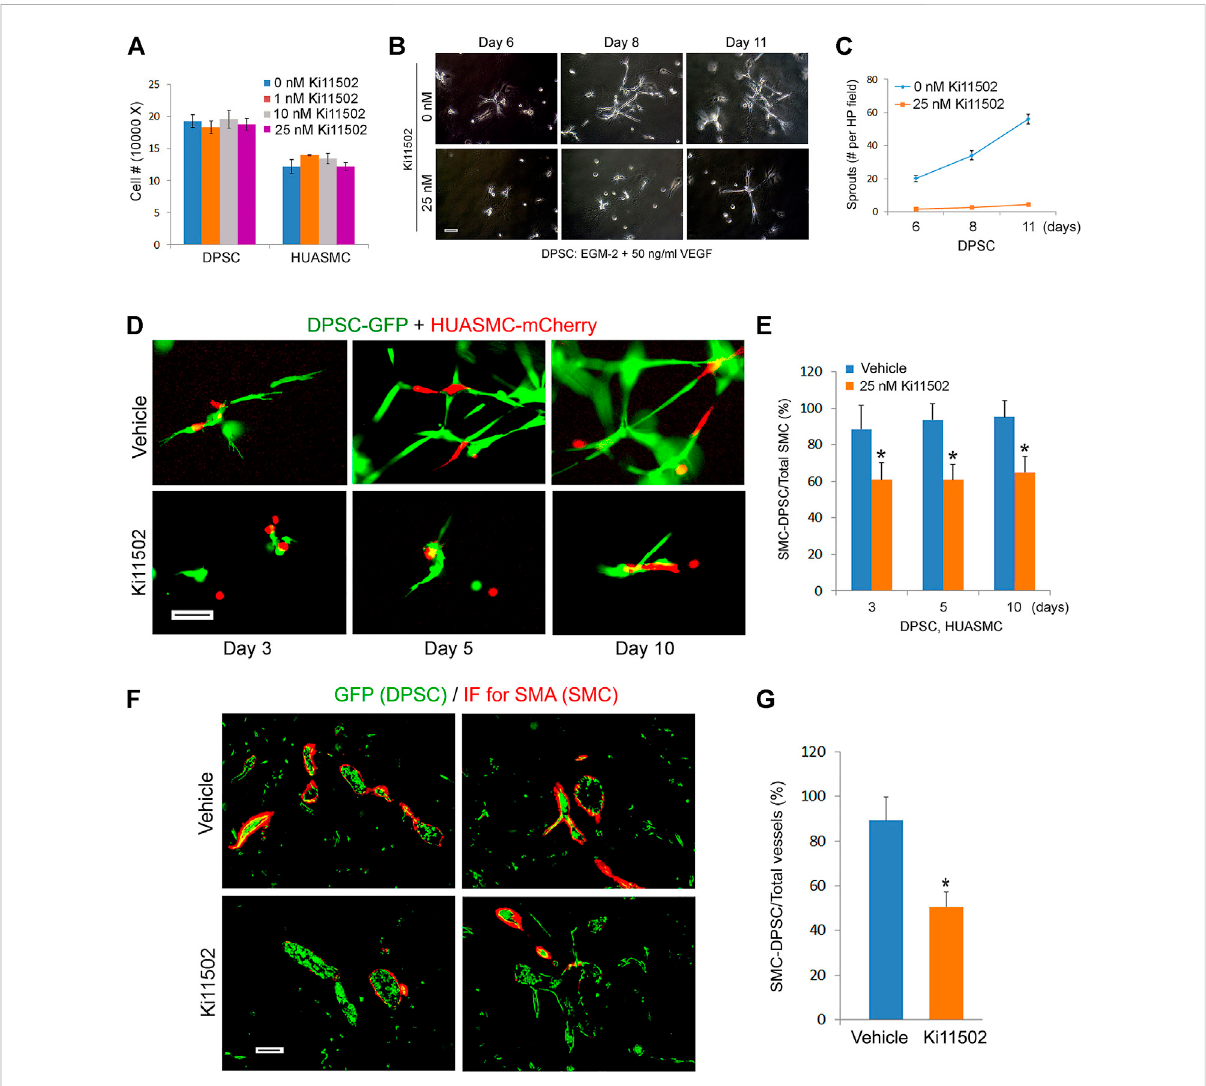
FIGURE 6 Blockade of PDGFR- β signaling inhibits maturation of DPSC-derived blood vessels in vitro and in vivo . (A) 10000 – 50000 DPSC or HUASMC were cultured with α -MEM supplemented with 5% FBS in presence of 0 – 25 nM Ki11502. After 4 days, the number of cells were counted under microscopic evaluation. (B,C) 10000 DPSC were plated in growth factor-reduced Matrigel-coated wells and cultured with EGM2-MV + 50 ng/ml VEGF in presence of 0 or 25 nM Ki11502 (PDGFR inhibitor) for indicated time points. Photomicrographs of capillary-like sprouts. Scale bar: 100 µm. (C) Graph depicting the number of capillary-like sprouts from (B) . (D,E) DPSC (green) and HUASMC (red) were seeded in Matrigel-coated plates and cultured with α -MEM supplemented with 5% FBS in presence of 20 ng/ml bFGF and PDGF-BB in the presence of 25 nM Ki11502 for indicated time points. Vascular networks were photographed. Scale bar: 100 µm. (E) Graph depicting the percentage of HUASMC cells in direct contact with DPSC cells as a fraction of the total number of HUASMC cells in the microscopic fi eld. Asterisks depict p < 0.001. (F,G) 1000000 GFP- transduced DPSC cells were seeded in scaffolds and transplanted into the subcutaneous space of immunode fi cient mice. After 3 weeks, mice ( n = 5per group) were treated with vehicle (control) or with 5 mg/kg Ki11502by oral gavage, once aday for 7 days. After 4 weeks, mice wereeuthanized, scaffolds were removed, fi xed, and prepared for HE and immuno fl uorescence staining. (F) Immuno fl uorescence for GFP (DPSC, green) and SMA- α (mouse mural cells, red) double staining. (G) Graph depicting the percentage of blood vessels covered by SMA- α cells as compared to total blood vessels from (F) . Asterisk depicts p <